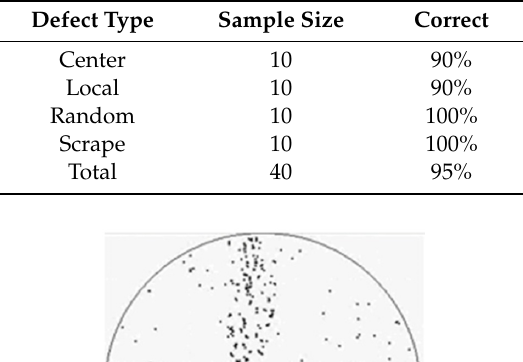
Table 4. CNN validation results.